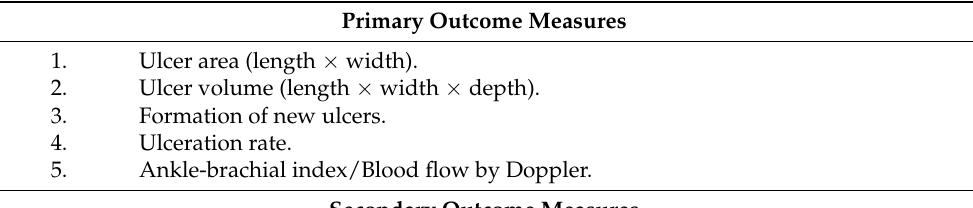
Table 2. Primary and secondary outcome